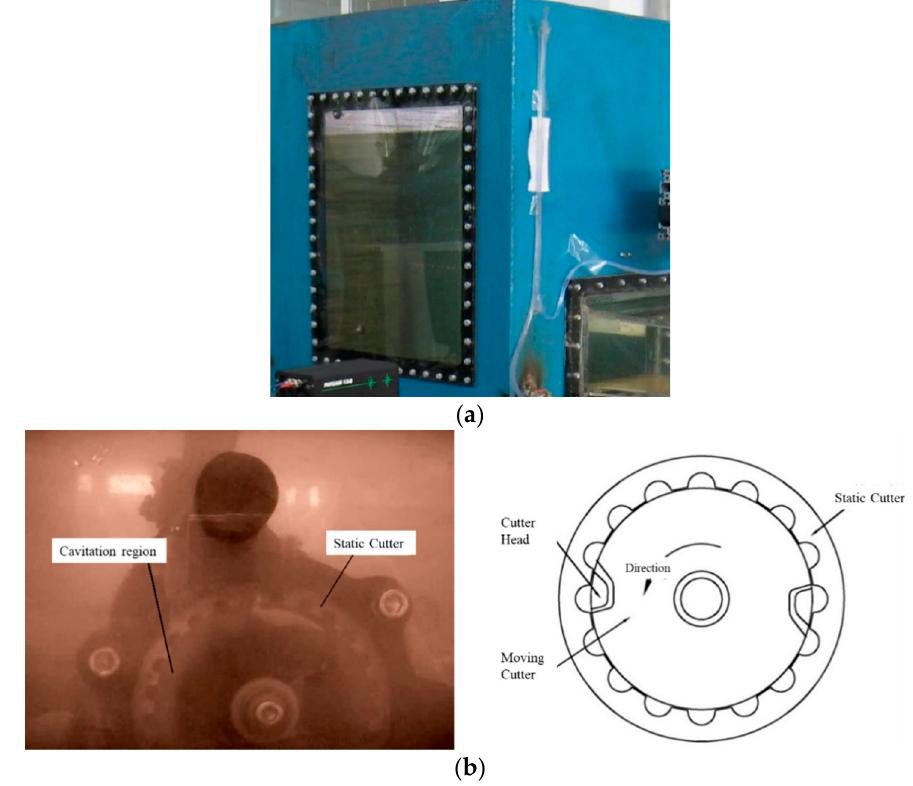
Figure 20. Cutter cavitation test. ( a ) test water tank, ( b ) Cutter cavitation.